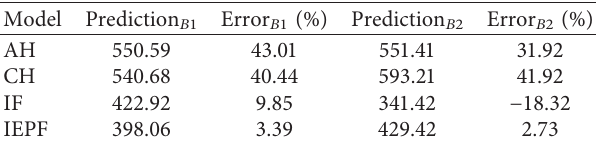
Table 10: Ultimate bearing capacity prediction for example 2.